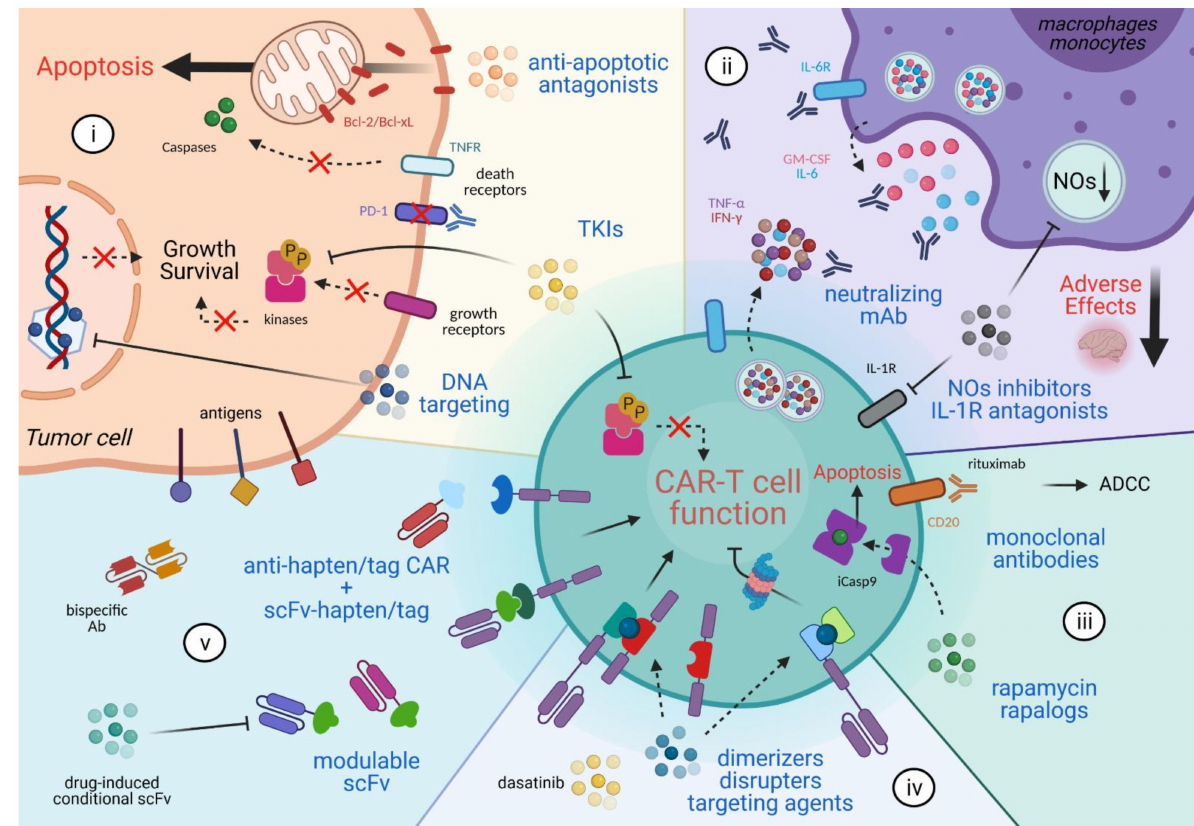
Figure 1. Overview of the pharmacologic interventions exploited with CAR T cells. (i) Combinatorial anti-cancer approaches. (ii) Mitigating adverse effects. (iii) CAR T cell elimination. (iv) Reversible control of CAR. (v) Modulating CAR specificity. See the main text for description. Created with